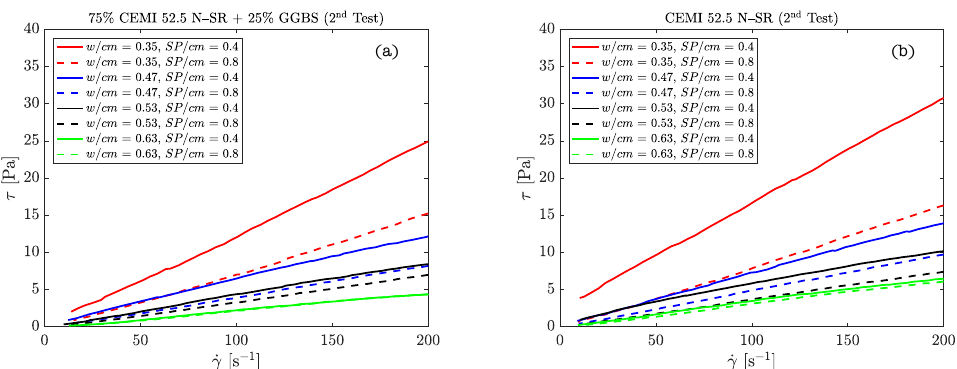
Figure 2. Descending branches of the flow curves of cement pastes obtained with the rotational double cone-plate rheometer: ( a ) 75% CEM I 52.5 N-SR + 25% ground granulated blast-furnace slag (GGBS); ( b ) CEM I 52.5